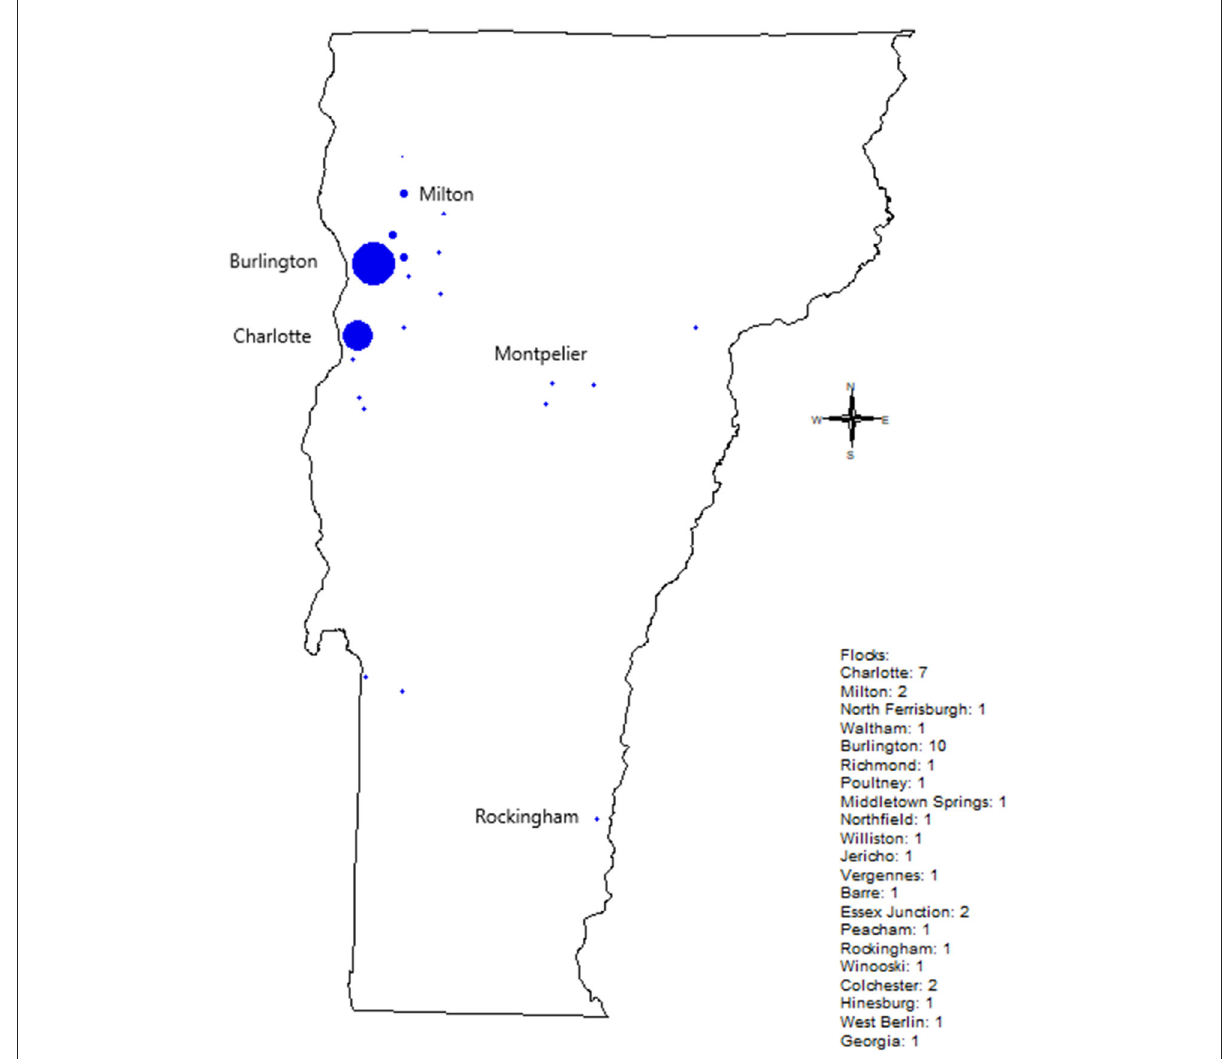
FIGURE1 Backyard flocks sampled in Vermont by City. Circle size indicates the number of flocks tested, with numbers to the right of the figure.